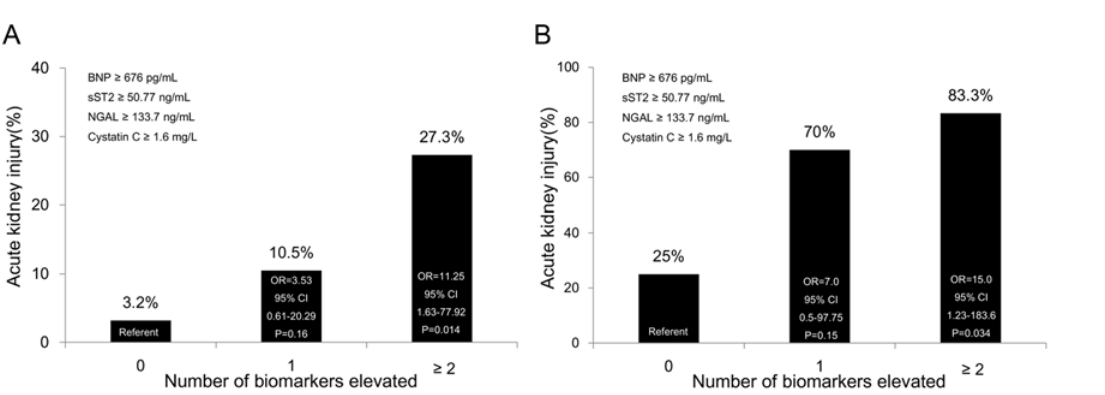
Fig 3. Number of biomarkers elevated higher than the cutoff values and the risk of developing acute kidney injury within 48 hours: (A) patients with creatinine levels < 1.24 mg/dL; (B) patients with creatinine level (cid:1) 1.24 mg/dL. Regardless of the creatinine level on admission, elevation of (cid:1) 2 of the biomarkers higher than the cutoff values provided incremental value in risk stratification of acute kidney injury.